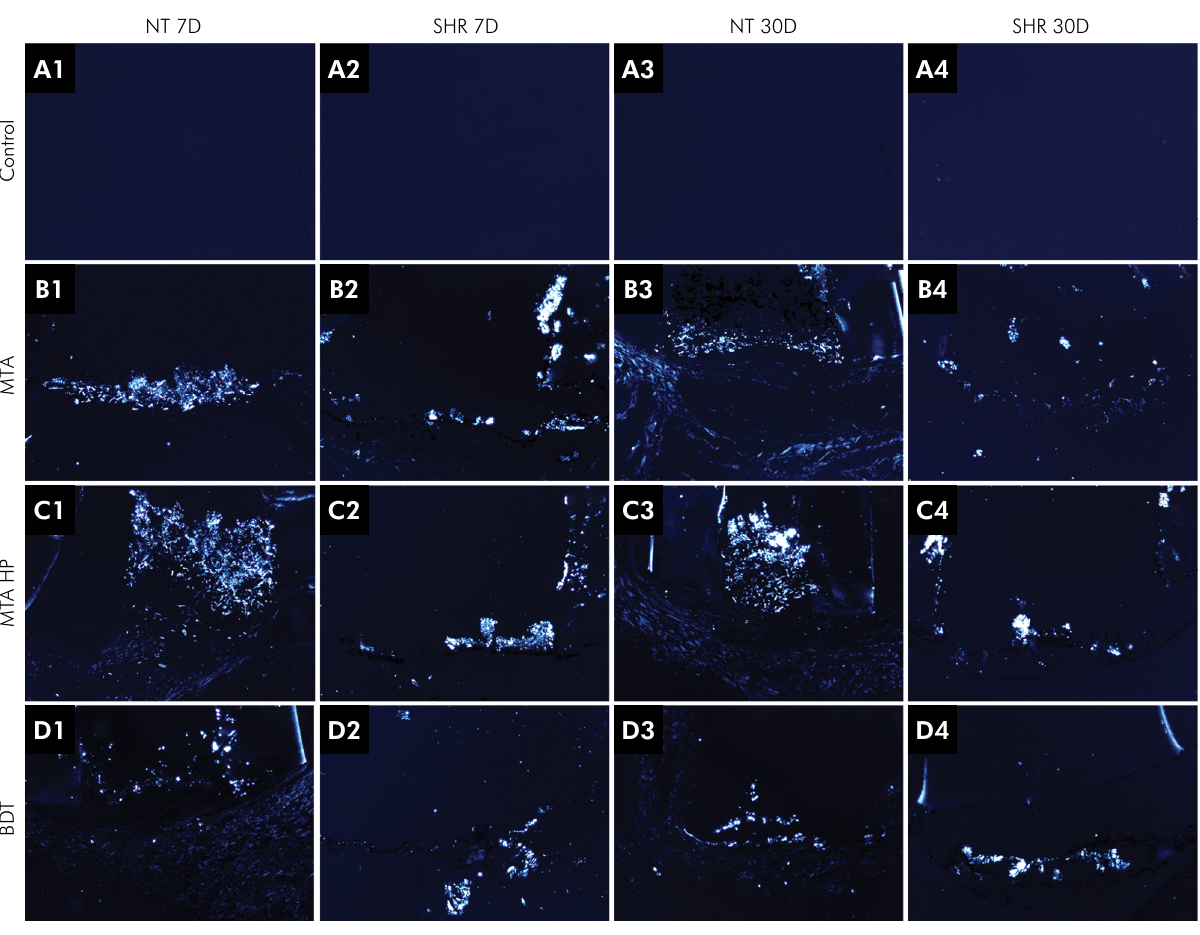
Figure 3. Representative images of biomineralization determined by polarized light microscopy under normotensive/hypertensive conditions (NT/SHR). Birefringent structures in the tissue represent presence of calcifications. MTA, MTA HP, and BDT induced biomineralization, which was not observed in the control group. More consistent biomineralization was observed in MTA, MTA HP, and BDT under normotensive conditions, especially at 7 days (Scale bars: 200 μ m; Original magnification: 100×). *Mineral Trioxide Aggregate (MTA), High-plasticity MTA (MTA HP), and Biodentine ®